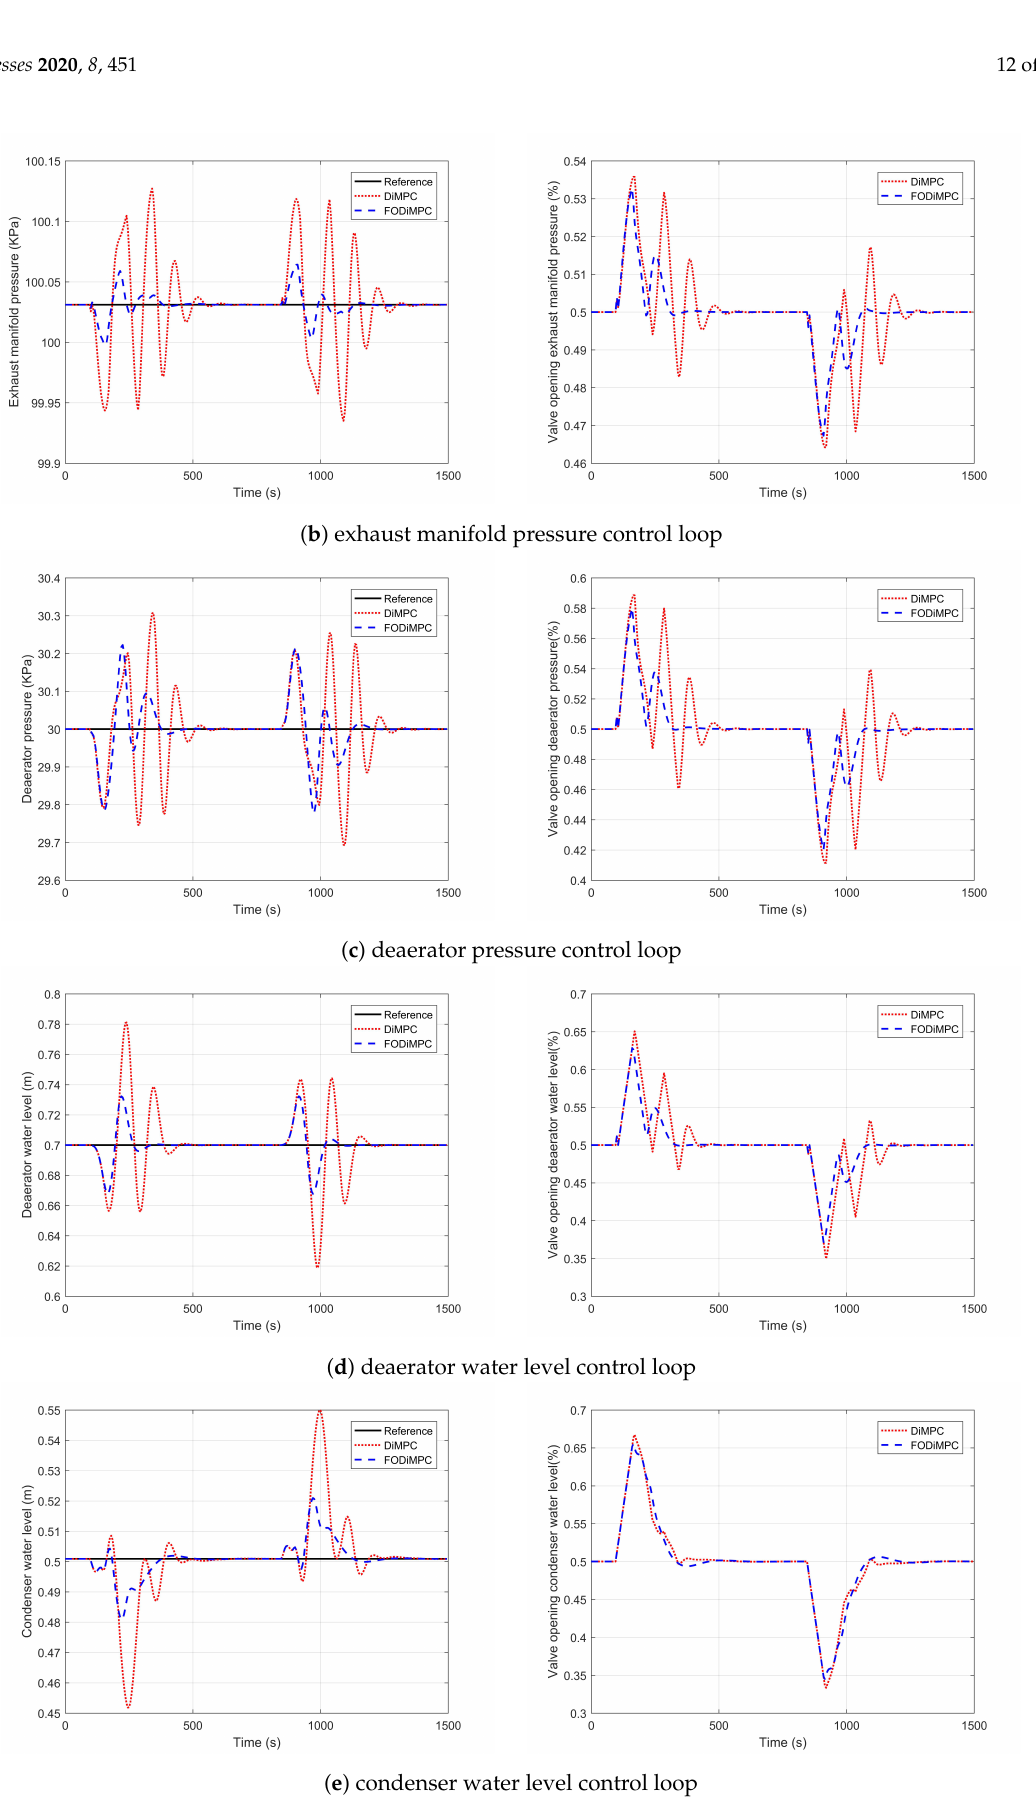
Figure 4. Outputs variables with FOMPC and MPC in the load fluctuation experiment (The outputs are listed on the left hand, and the inputs are listed on the right